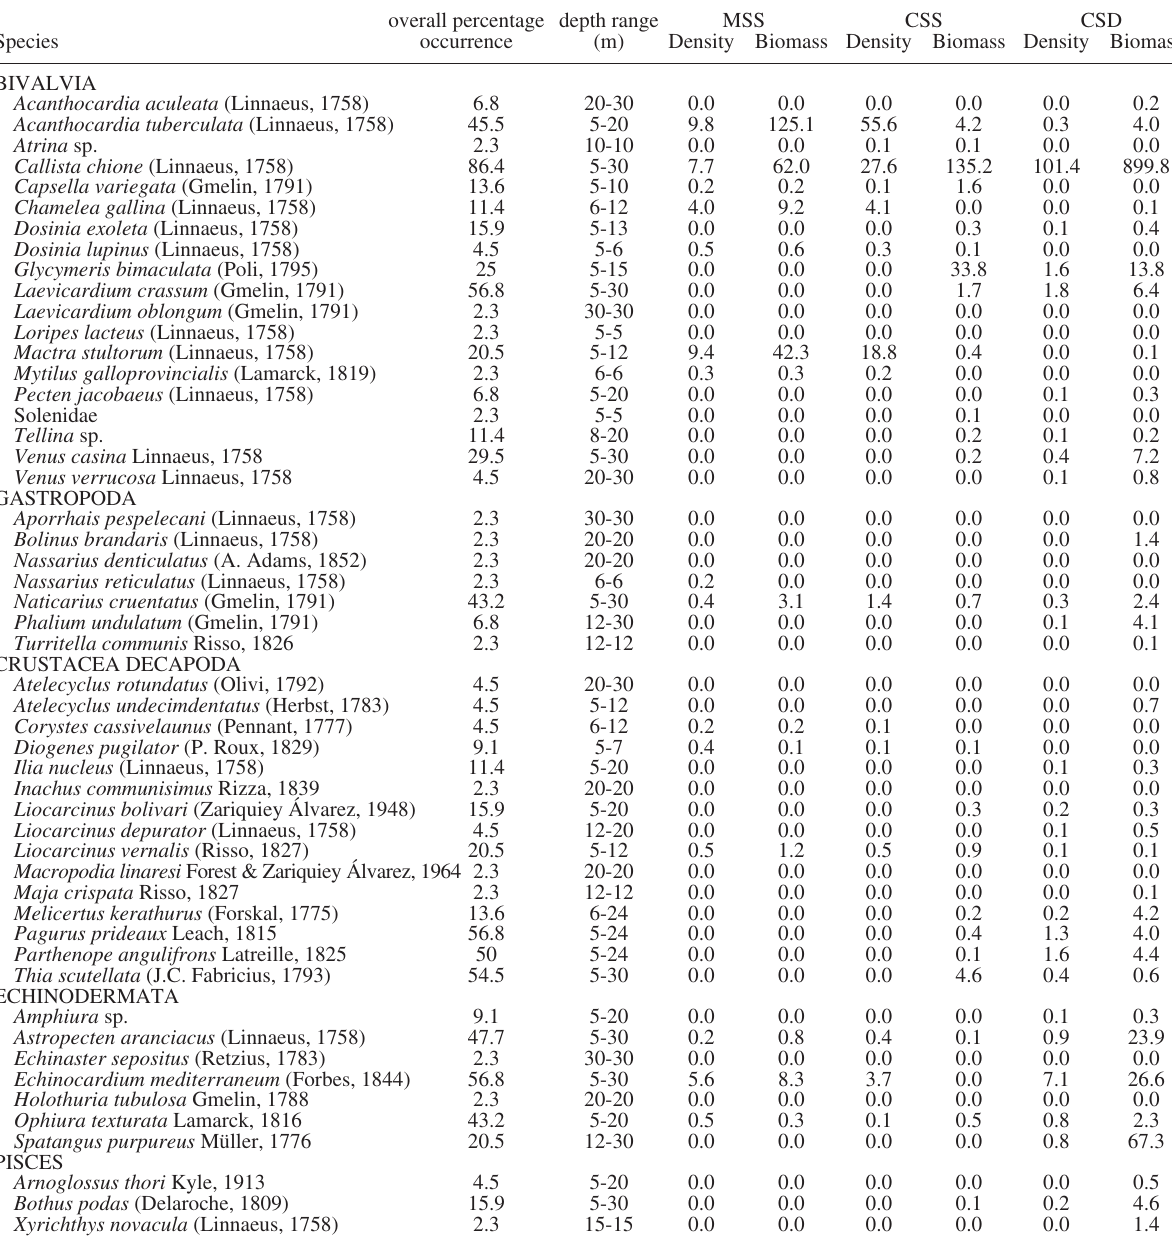
Table 1. – List of species, overall percentage occurrence (n=44 samples), depth range, and mean density (in number of individuals/200 m 2 ) and biomass (in g/200 m 2 ) of each species within each assemblage identified: MSS (Medium Sand Shallow), CSS (Coarse Sand Shallow) and CSD (Coarse Sand